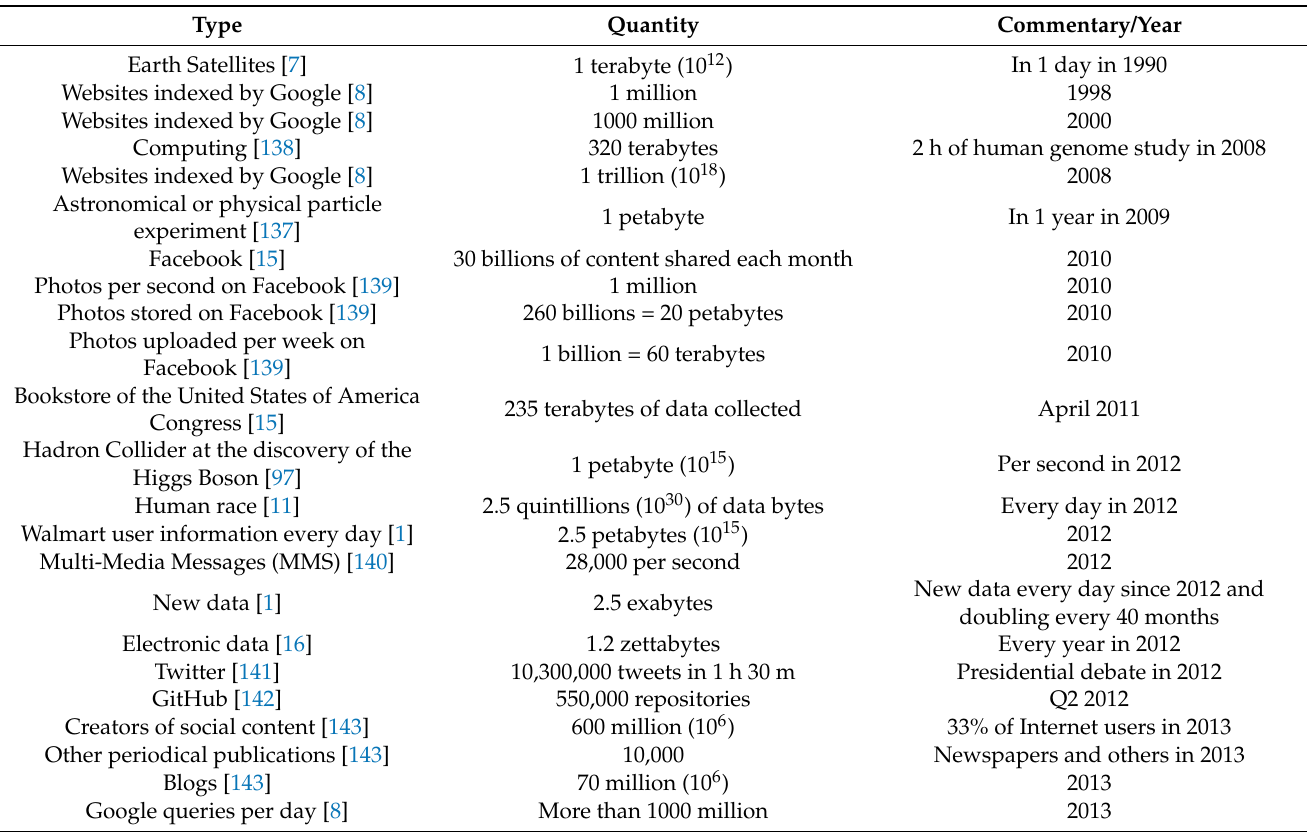
Table 5. Big Data